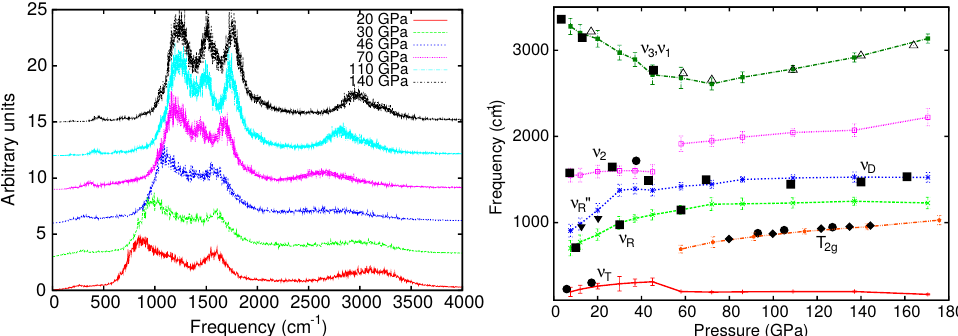
Figure 10. ( Left panel ): ice spectra obtained through the Fourier transform of the velocity-velocity autocorrelation function from QTB simulations at several pressures [1]. ( Right panel ): the peaks extracted from the QTB ice spectra (lines) are compared to the experimental infrared and Raman scattering data (triangles and